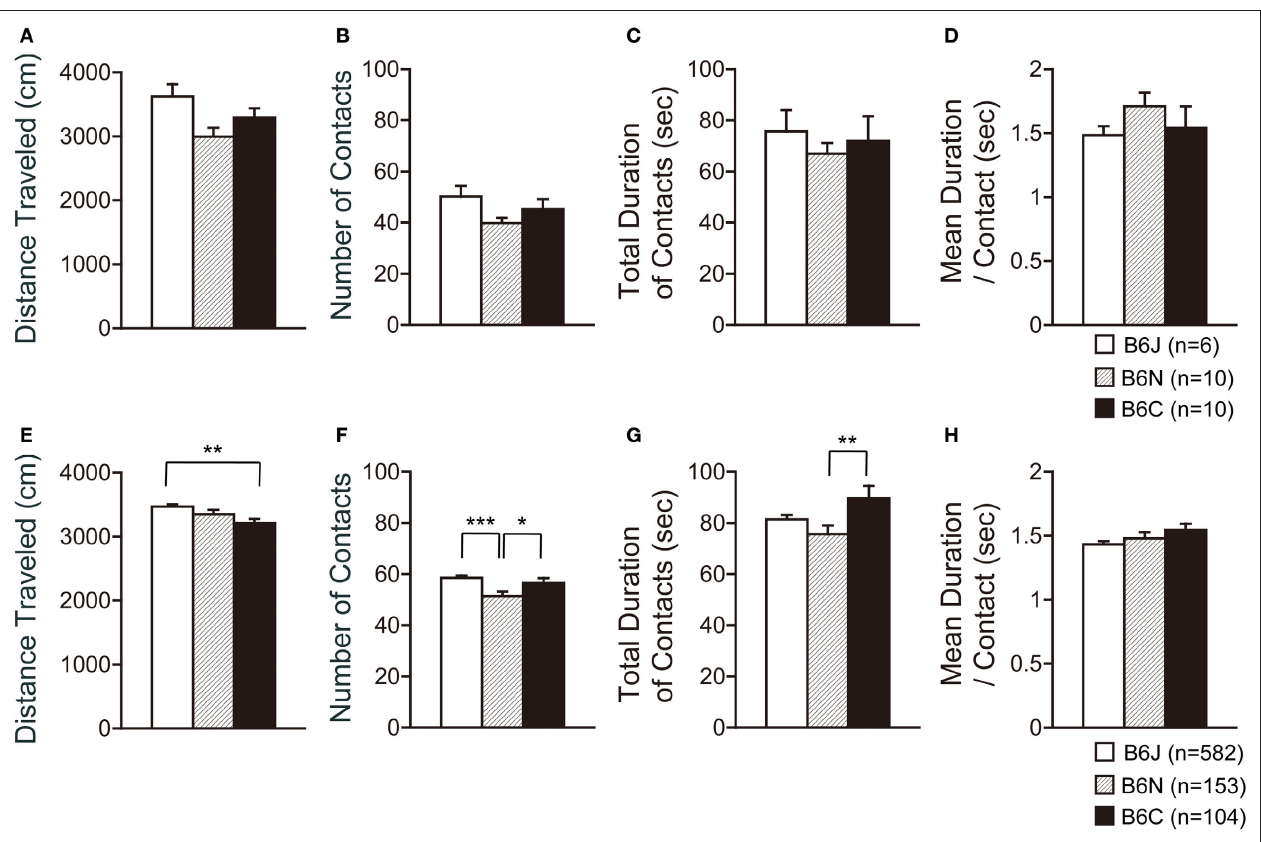
Figure 6 | Social interaction test of C57BL/6 substrains. (A–D) Regular scale analysis. (e–H) Large-scale analysis. (A,e) Total distance traveled. (B,F) Number of contacts. (C,g) Total duration of contacts. (D,H) Mean duration per contacts. * p < 0.05, ** p < 0.01, *** p < 0.0001. Error bars indicate